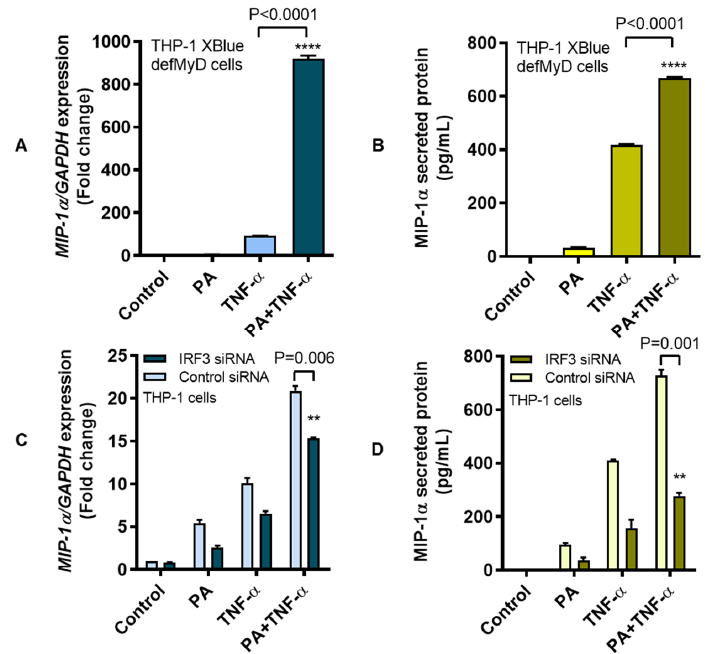
Figure 4. MIP-1 α co-induction by palmitate and TNF- α involves the IRF3 pathway. To investigate whether the MIP-1 α co-induction by palmitate and TNF- α required MyD88 adaptor protein for TLR4-downstream signaling, we used MyD88-null THP1-XBlue-defMyD cells and treated cell cultures at 37 ◦ C with palmitate (200 µ M) and / or TNF- α (10 ng / mL) for 24 h. Cell pellets were collected for total RNA extraction for measuring MIP-1 α gene expression and cells supernatants were collected for measuring MIP-1 α secreted protein as described in the Materials and Methods section. The representative data (mean ± SEM) from three independent determinations with similar results show that MIP-1 α co-induction by palmitate and TNF- α was sustained in MyD88-defective cells which showed elevated expression of ( A ) MIP-1 α transcripts ( P < 0.0001) and ( B ) MIP-1 α secreted protein ( P < 0.0001) in response to co-stimulation with palmitate and TNF- α as compared to those treated with either TNF- α or palmitate. On the contrary, siRNA-mediated ablation of IRF3 resulted in the diminution of ( C ) MIP-1 α mRNA ( P = 0.006) and ( D ) MIP-1 α secreted protein ( P = 0.001) compared to controls transfected with scrambled siRNA. Thus, MIP-1 α co-induction in THP-1 cells by palmitate and TNF- α involves the IRF3-mediated signaling. ** P < 0.01 and **** P <